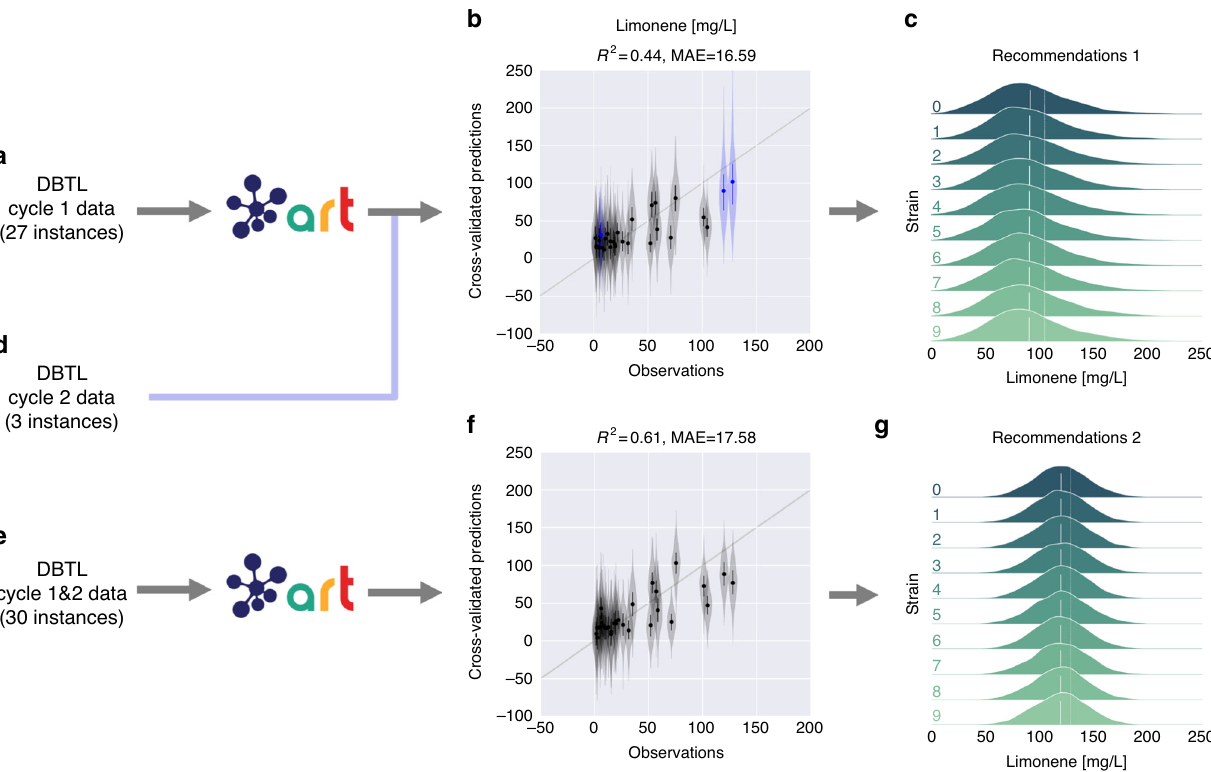
Fig. 6 ART provides effective recommendations to improve biofuel production. We used the fi rst DBTL cycle data ( a ) to train ART and recommend new protein targets with predicted production ( c ). The ART recommendations were very similar to the protein pro fi les that eventually led to a 40% increase in production (Fig. 7). ART predicts mean production levels for the second DBTL cycle strains ( d ), which are very close to the experimentally measured values (three blue points in b ). Adding those three points from DBTL cycle 2 provides a total of 30 strains for training ( e ) that lead to recommendations predicted to exhibit higher production and narrower distributions ( g ). Uncertainty for predictions is shown as probability distributions for recommendations ( c , g ) and violin plots for the cross-validated predictions ( b , f ). The cross-validation graphs (present in Figs. 8, 9 and Supplementary Figs. 8, 9, too) represent an effective way of visualizing prediction accuracy for data the algorithm has not yet seen. The closer the points are to the diagonal line (predictions matching observations) the more accurate the model. The training data are randomly subsampled into partitions, each of which is used to validate the model trained with the rest of the data. The black points and the violins represent the mean values and the uncertainty in predictions, respectively. R 2 and mean absolute error (MAE) values are only for cross-validated mean predictions (black data